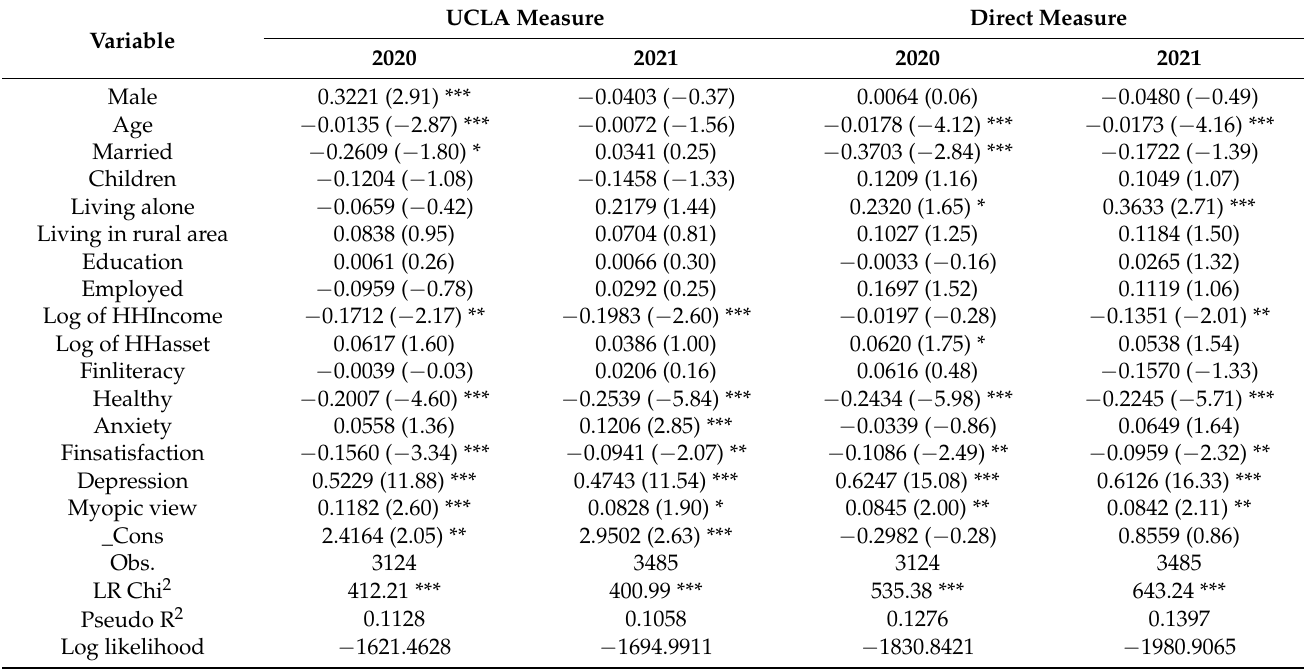
Table 6. Logit regression analysis for loneliness before and during the COVID-19 pandemic for the younger sub-sample. Variable